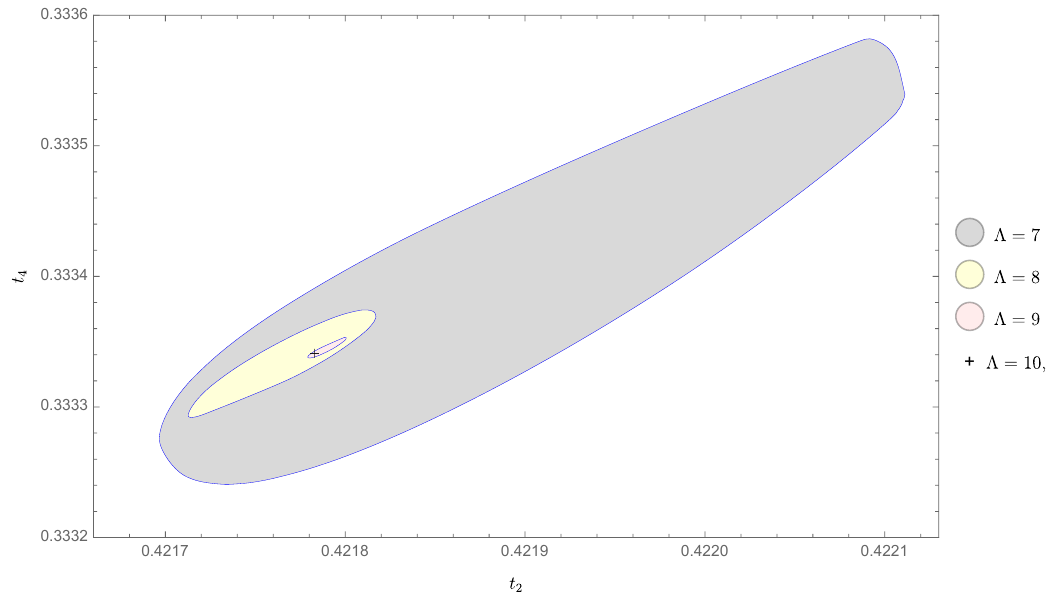
Figure 4 . The allowed region of t 2 − t 4 of model (5.1) with parameter g = 1 , h = 1 for the cutoff Λ = 7 , 8 , 9 , 10 , 11 . We recall the definition of Λ : the longest operators in the correlation matrix and in the loop equations have the length 2Λ